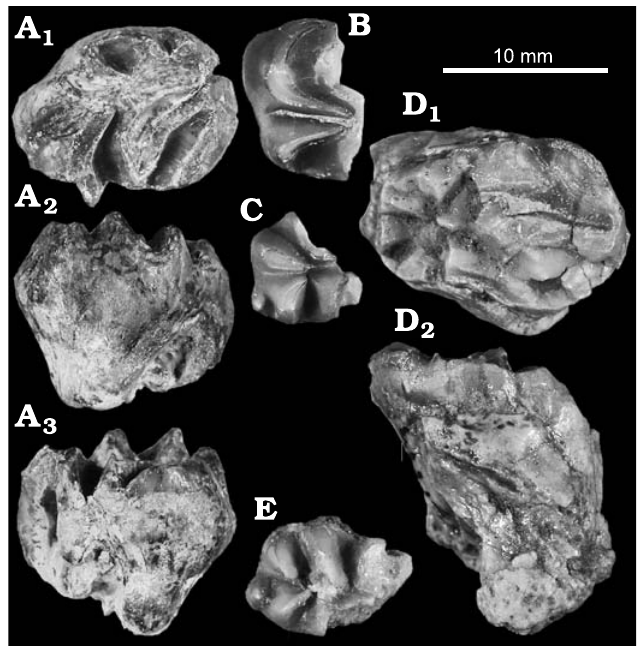
Fig. 2. Multituberculate mammal Sphenopsalis nobilis Matthew, Gran ger, and Simpson, 1928 from the late Paleocene Gashato Formation at Shabarakh Usu, Mongolia. A . Holotype (AMNH 21736), the upper left M2 in occlusal, lingual and buccal views (A 1 –A 3 ). B . Paratype (AMNH 21713), anterior part of a left m2 in occlusal view. C . Paratype (AMNH 21715), anterior parts of a left m1 in occlusal view. D . AMNH 21719.001, broken ?M2 in occlusal (D 1 ) and lateral (D 2 ) views. E . AMNH 21719.002, anterior parts of a left m1 in occlusal view.